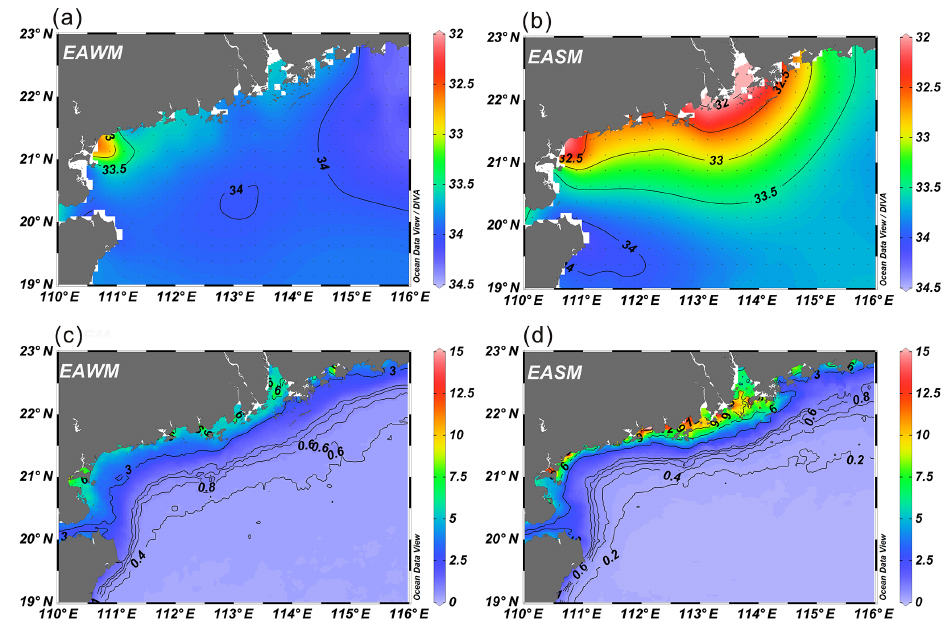
Figure 3. Spatial distribution of surface salinity in the northern SCS during the (a) EAWM and (b) EASM seasons of 2005–2017 and of surface Chl a concentration (mgm − 3 ) in the (c) EAWM and (d) EASM seasons of 2005–2017. (cid:48) between U K and averaged SSTs of various depths (0, 10, 37